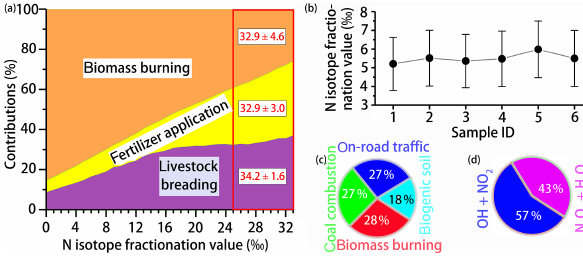
Figure 3. (a) Source partitioning estimates for NH + in cloud wa- 4 . The red square highlights the ter as a function of ε NH + − NH 3 4 ≥ 25‰. (b) Whisker best-guess estimates based on ε NH + − NH 3 4 plot of the N fractionation for the conversation of NO x to NO − 3 ) calculated by the computational quantum chemistry ( ε NH + 4 − NH 3 (CQC) module. The upper line, dot, and bottom line indicate the 25th percentile, median, and 75th percentile, respectively. Refer to Table 1 for sample ID. (c) Overall contribution of various NO x sources to NO − in cloud water as estimated by the MixSIR model. 3 (d) Overall contribution of the two dominant pathways to NO − for- 3 mation in cloud water, as estimated by the MixSIR